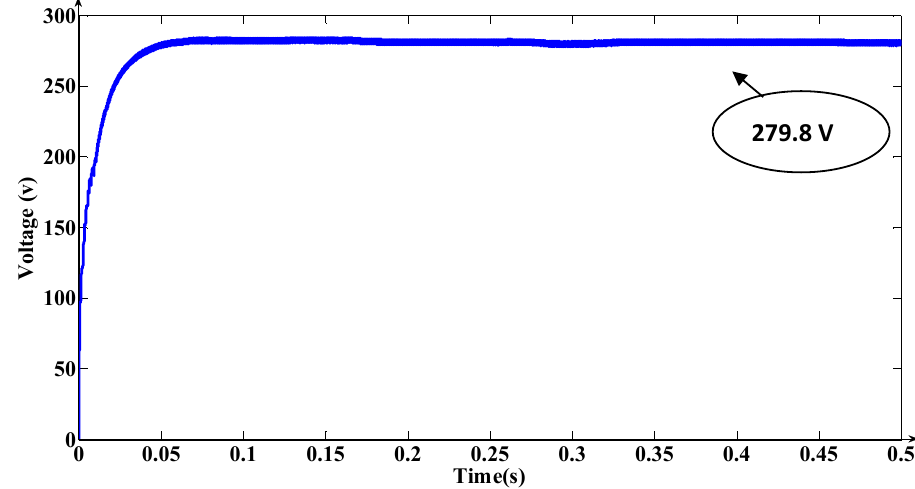
Figure 37. Output voltage waveform for PI-controlled bidirectional converter (BDC).